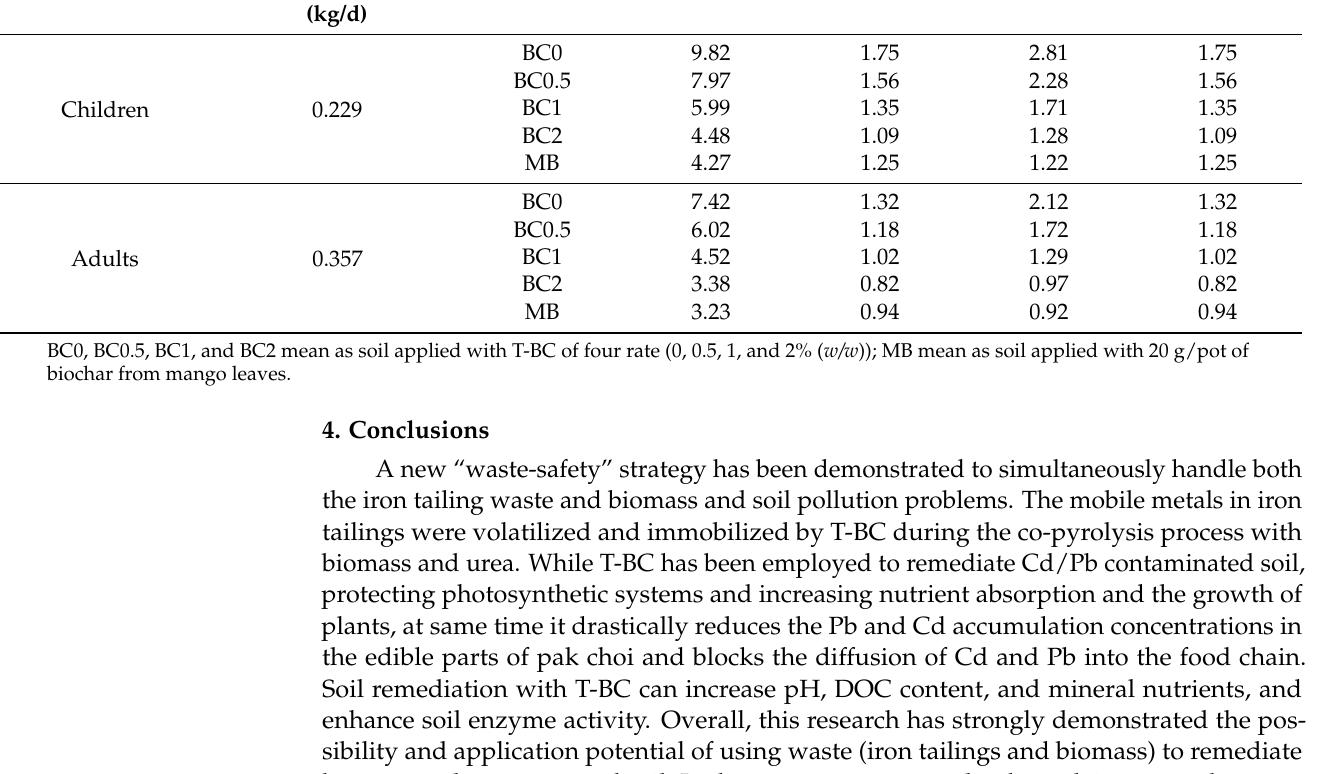
Table 3; children ingested ( μ g·kg − 1 ·d − 1 ) Pb (4.48 and 4.27) and Cd (1.09 and 1.25) daily